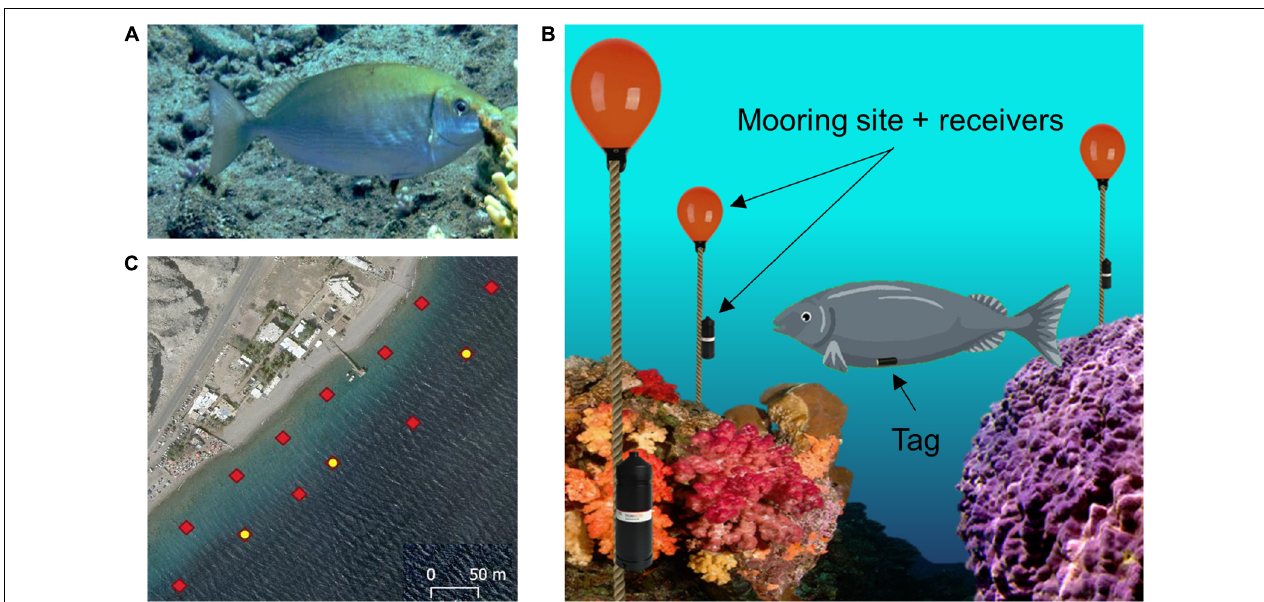
FIGURE 2 | Experimental setup. (A) Profile view of a rivulated rabbitfish ( Siganus rivulatus ). (B) Illustration of the acoustic tracking system. The fish is fitted with an acoustic tag in the abdominal cavity. An array of acoustic receivers is attached to mooring sites spread throughout the reef environment. (C) Array layout deployed in the reef: red diamonds indicate each receiver station; the yellow dots indicate stations with an attached sync tag, which are used for synchronization of the clocks of all the